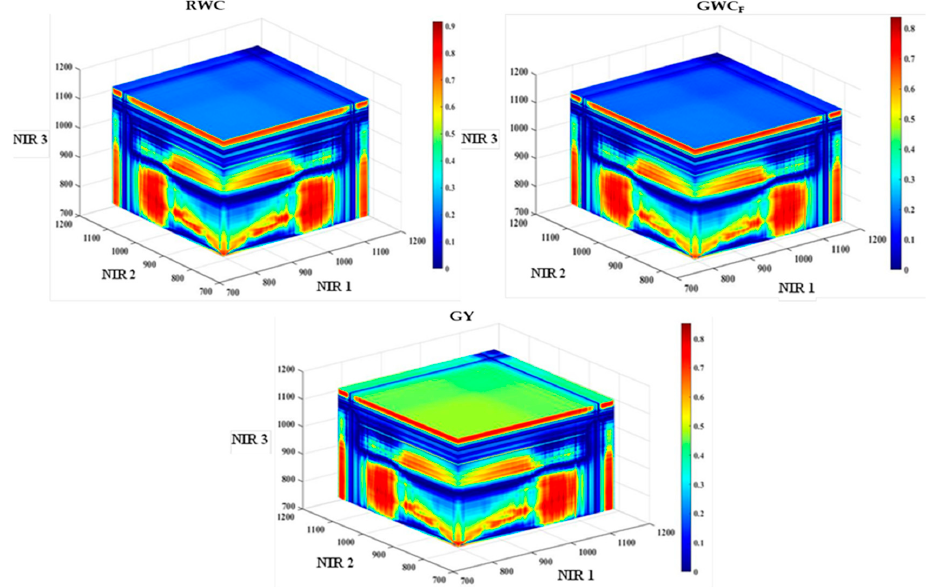
Figure 3. Three-dimensional (3-D) correlogram maps showing the coefficients of determination (R2) between all possible three-band combinations in the range of 700 to 1148 nm (wavelength of red-red and NIR regions) and the relative water content (RLWC), gravimetric water content on a fresh weight basis (GWC F ), and grain yield (GY) using the pooled data of the wheat cultivars, seasons, irrigation regimes, and replications.